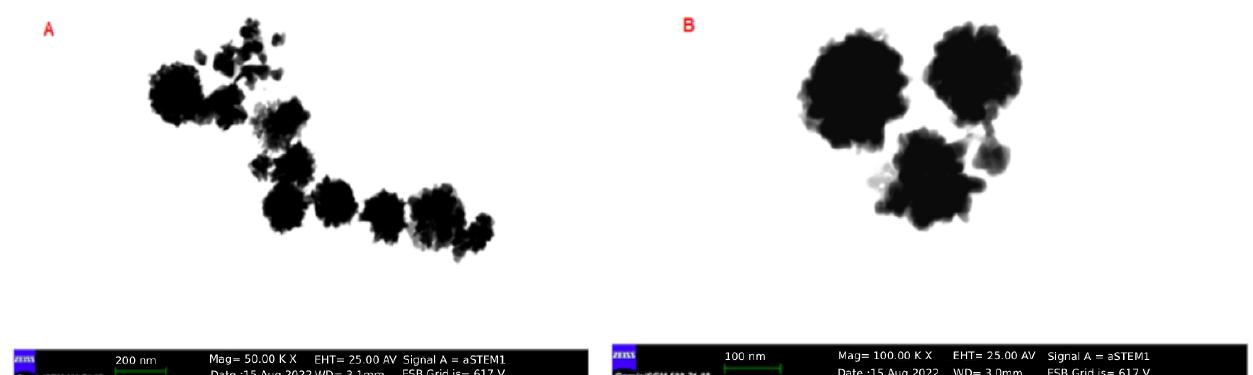
Figure 4. STEM image of R-AuNFs showing the particle shapes. ( A ) Dispersed R-AuNFs (bar scale: 200 nm); ( B ) magnified image (bar scale: 100 nm). The EDX spectrometer spectrum obtained from FE-SEM indicated that the obtained AuNFs were pure (Figure 5a,b). Additionally, elemental mapping analysis showed the maximum distribution of gold elements. The hydrodynamic diameter of the H-AuNFs and R-AuNFs were 69 and 160 nm, respectively, according to DLS analysis results. In addition, H-AuNFs and R-AuNFs had a negative zeta potential, indicating their high stability, with a charge of − 21 and − 27 mV, respectively.